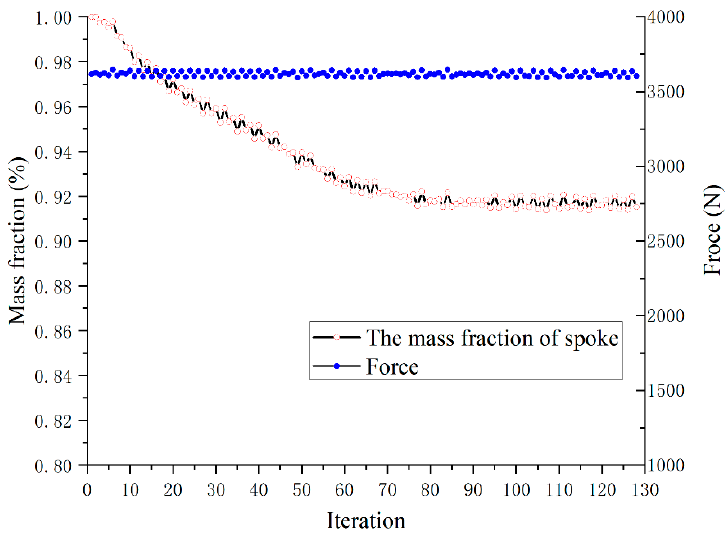
Figure 13. Optimized iterations for thickness in tire-radius direction.